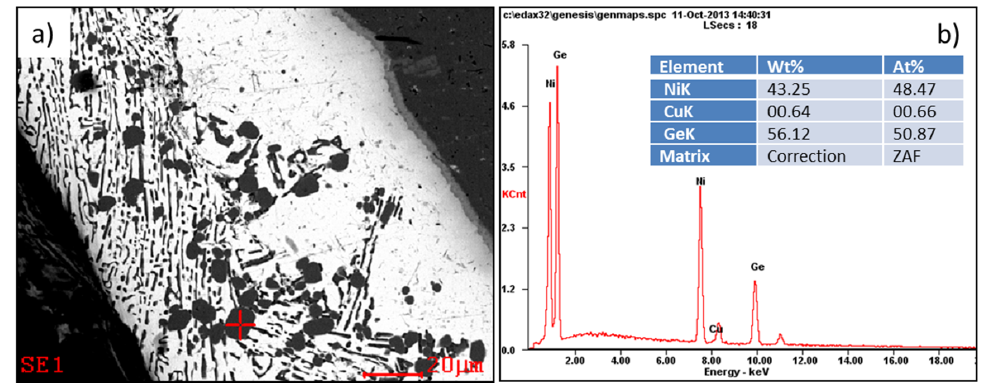
Figure 9. Cross-sectional SEM morphology of the sintered cylinder by magnification ( a ) and the EDS spectrum ( b ).